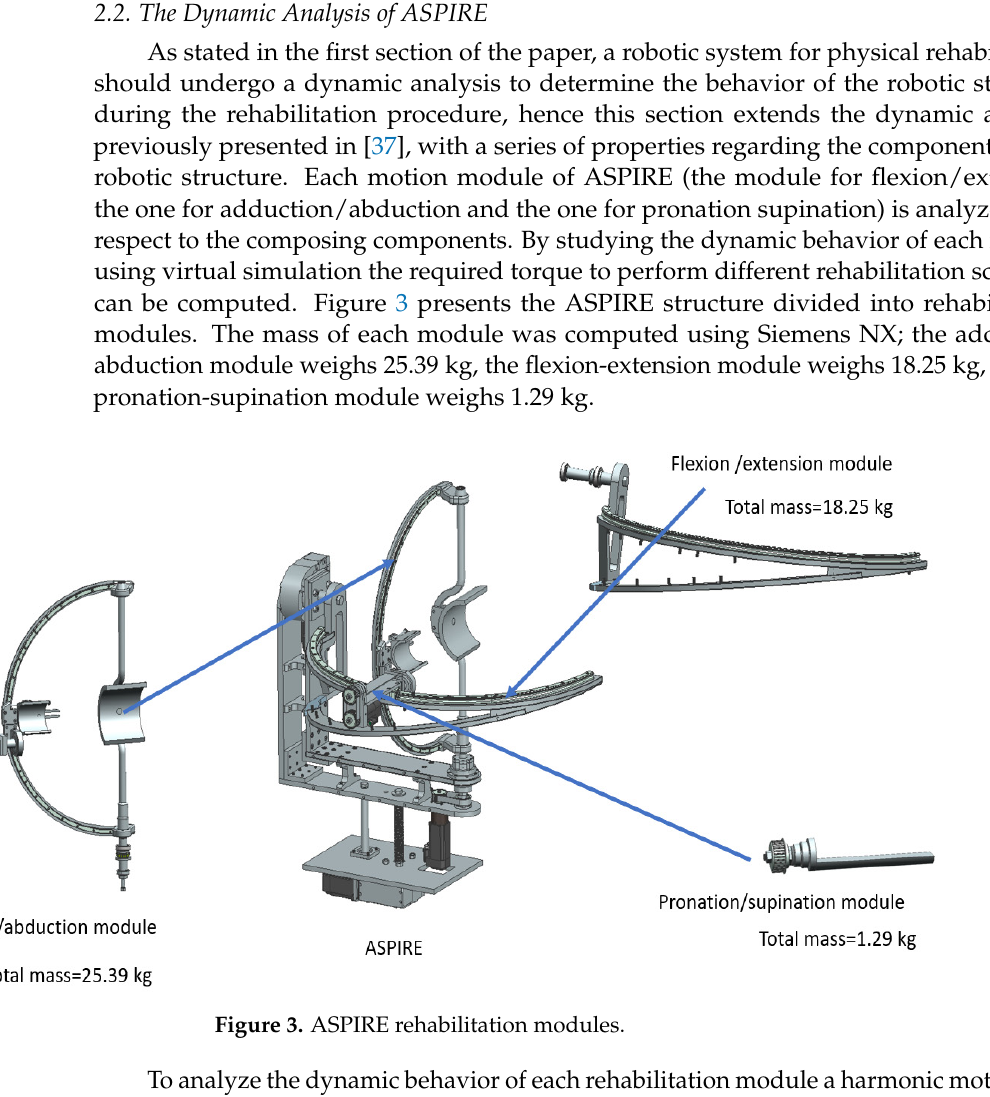
Table 2. Weight of upper-limb segment according to Plagenhoef [39].